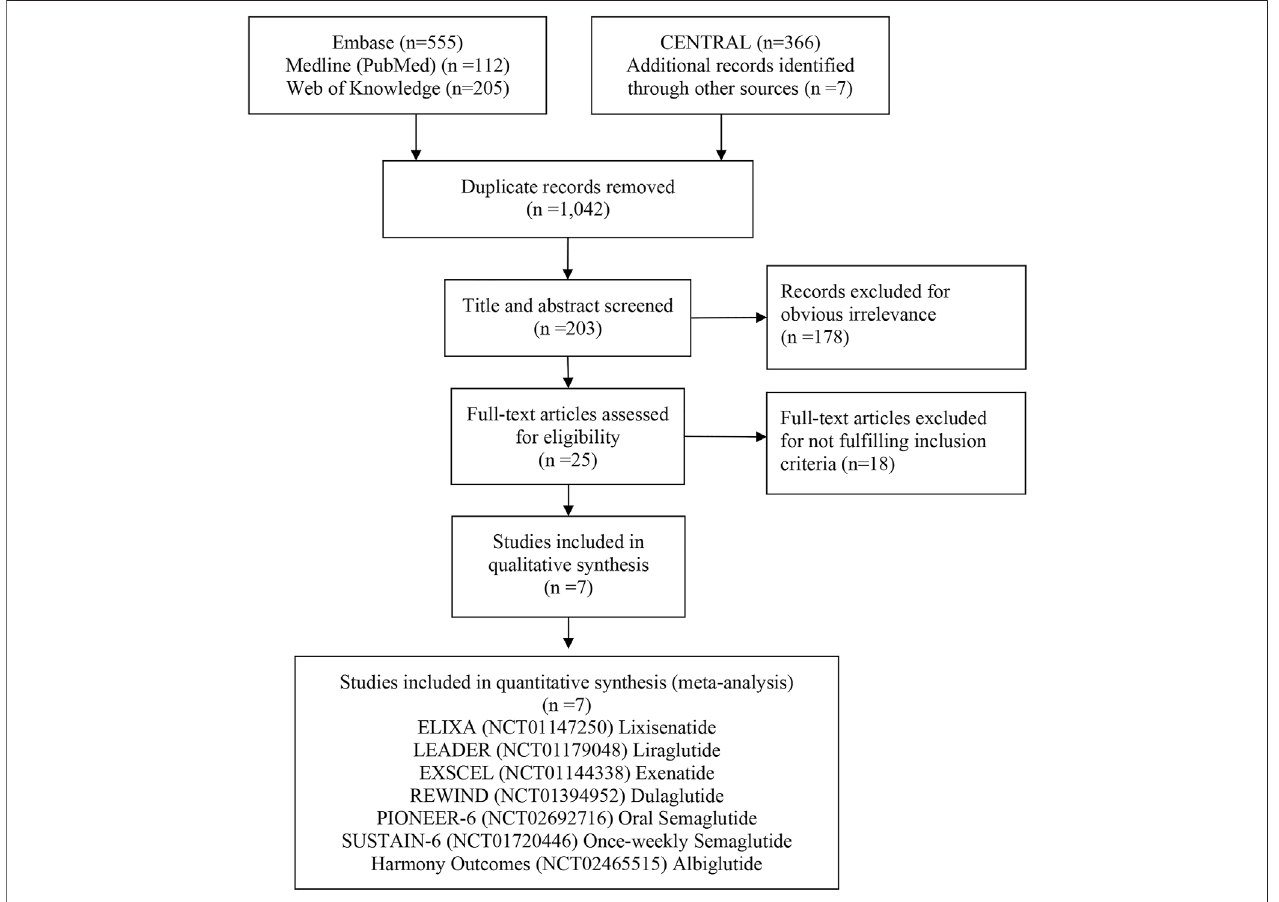
FIGURE 1 | Schematic illustration of the literature search and study selection performed.